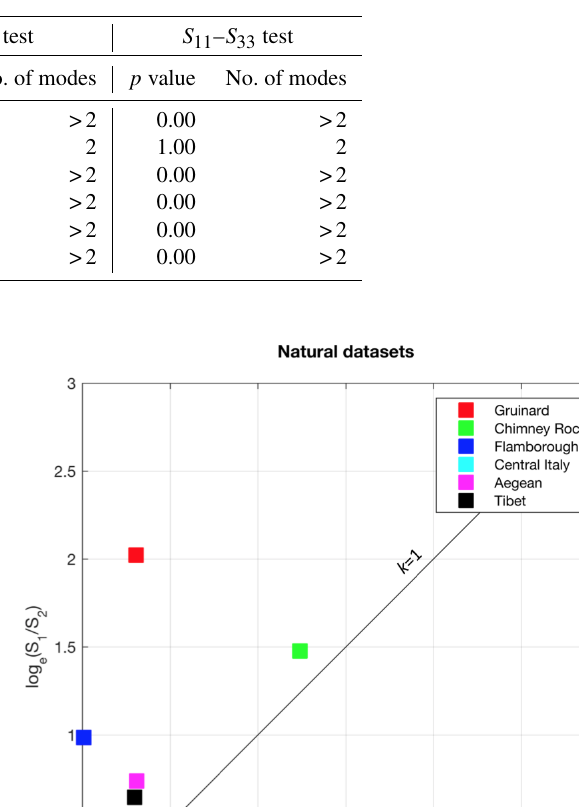
Table 3. The p values and corresponding decisions at the 5% significance level of randomisation tests of bimodality for natural datasets; n is the total sample size and B = 999 further randomisation samples per dataset (see text for details).